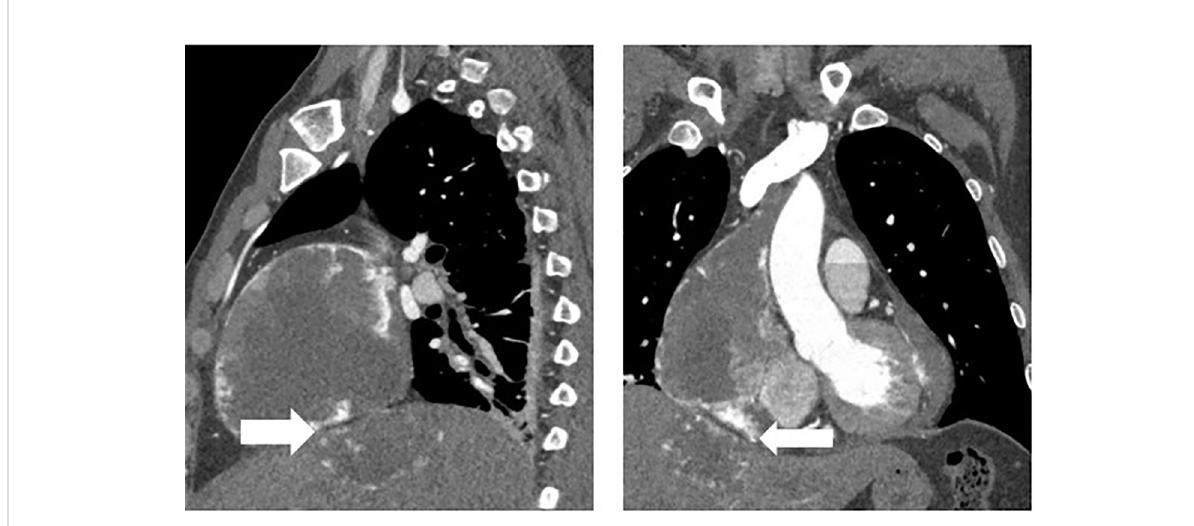
FIGURE 4 Direct invasion of the liver by a right atrial lesion(arrows).